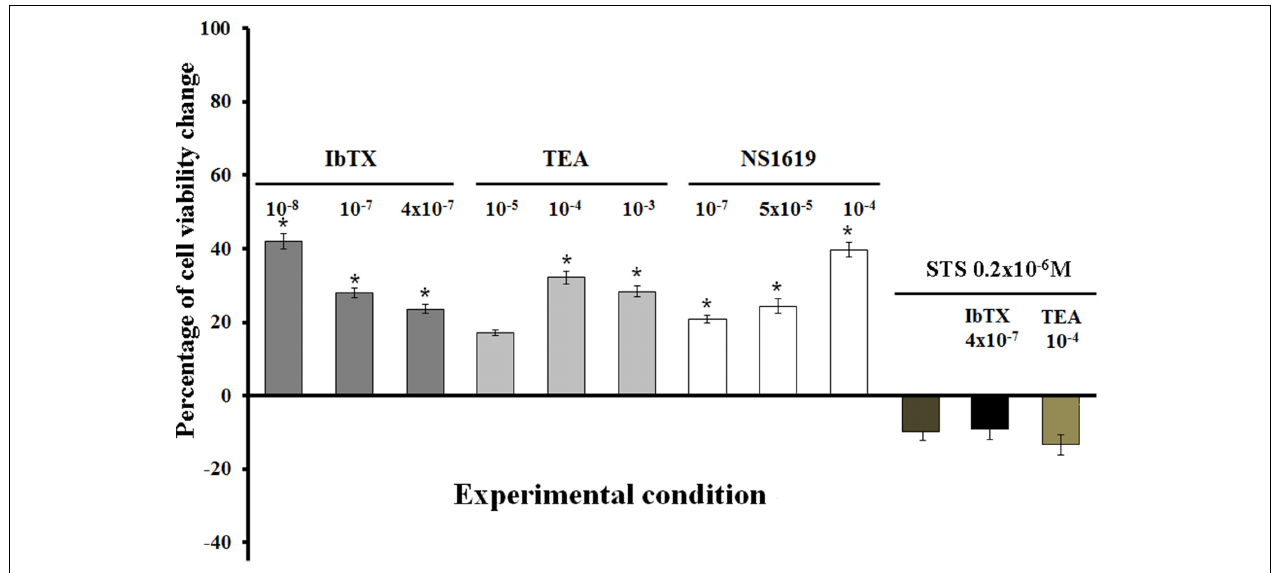
concentrations. The NS1619 enhanced cell proliferation showing a maximal proliferative effect of + 117%. The co-incubation of the cells with IbTX/TEA + STS(2 × 10 − 6 M) fully antagonized the proliferative actions of the IbTX and TEA, also leading to cell death in respect to the controls. ∗ Data significantly different with respect to the controls for p < 0 . 05 as determined by student t